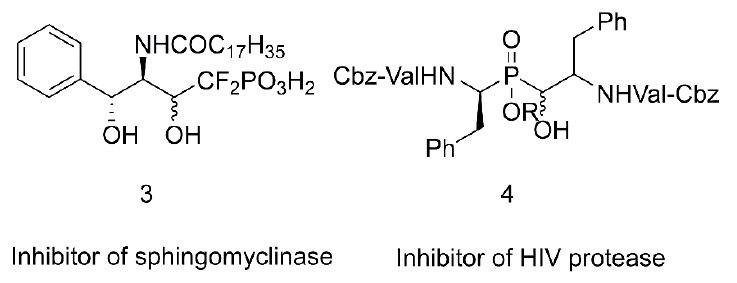
Figure 2. Examples of synthetic hydroxyphosphonates [19] .